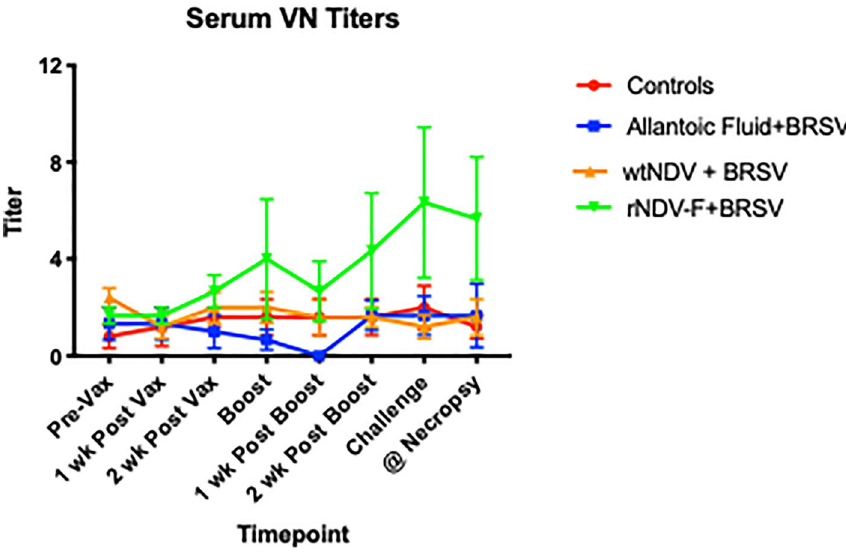
Figure 6. Serum neutralizing antibody titers measured following vaccination and BRSV challenge of colostrum-deprived calves. Sera was harvested from calves pre-vaccination and weekly following intranasal vaccination and diluted two-fold for determination of virus neutralization titers. Treatment groups of calves included: unvaccinated, uninfected controls (n = 5); intranasal (i.n.) allantoic fluid vaccinated (mock vaccine control) and BRSV challenged (n = 6); i.n. wtNDV-vaccinated and BRSV challenged (n = 5); i.n. rNDV-BRSV F opt vaccinated and BRSV challenged (n = 6). Data are presented as mean titer per group. Note that the only group of calves whose mean titer was 1:4 or higher was the group receiving i.n. vaccination with rNDV-BRSV F opt and this was sustained from boost to the end point of each of the 3 experiments.